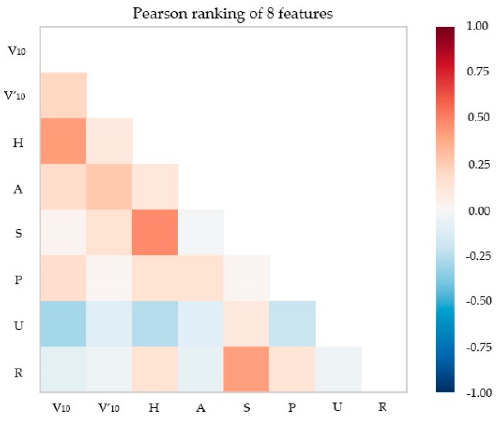
Figure 5. Correlation analysis of features.